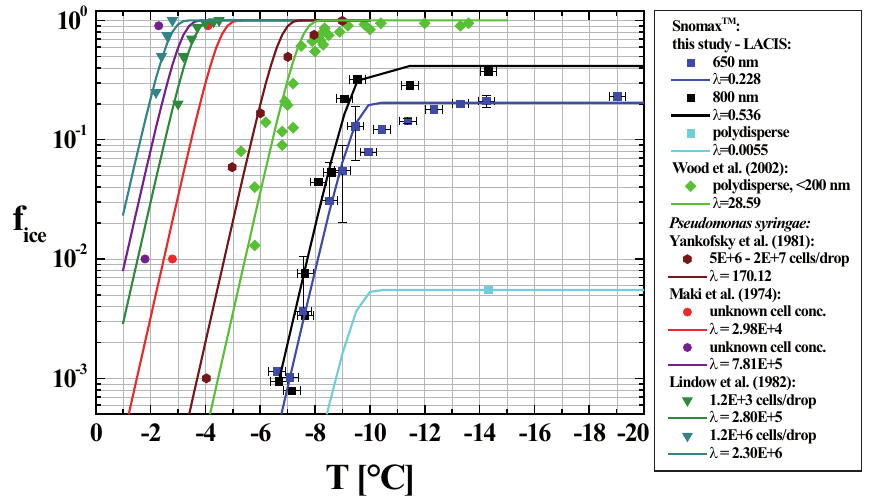
Fig. 8. A comparison of measured and calculated ice fractions obtained from the CHESS model with data from literature, see legend. Measured (data points) and calculated (lines) ice fractions f ice are given as function of temperature T